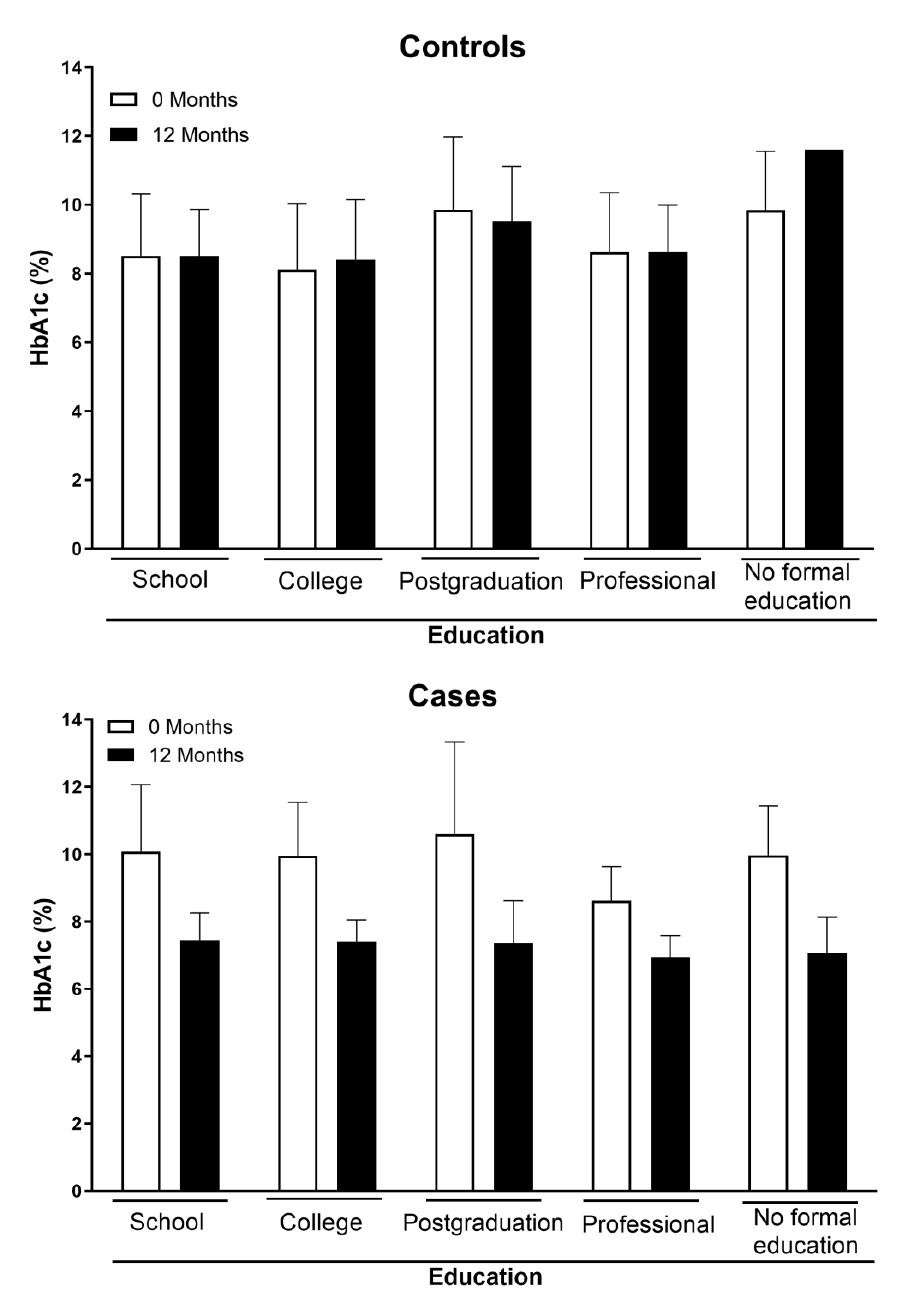
Figure 4. Phone call-based education decreased HbA1C level irrespective of the study